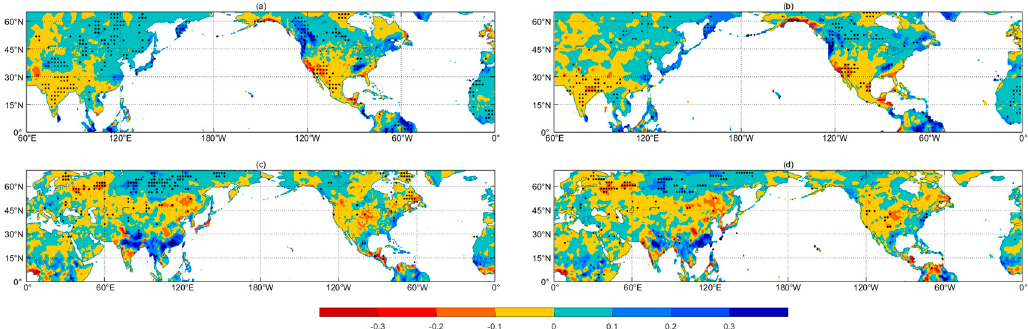
Figure 4. ( a , b ) Regressions of rainfall in boreal winter from ( a ) the Climatic Research Unit (CRU) and ( b ) the Global Rainfall Climatology Centre (GPCC) onto the NPIMV index. ( c , d ) Regressions of rainfall in austral winter from ( c ) CRU and ( d ) GPCC onto the SPIMV index. Values exceeding 90% for the significance test are dotted. Unit: mm/day.